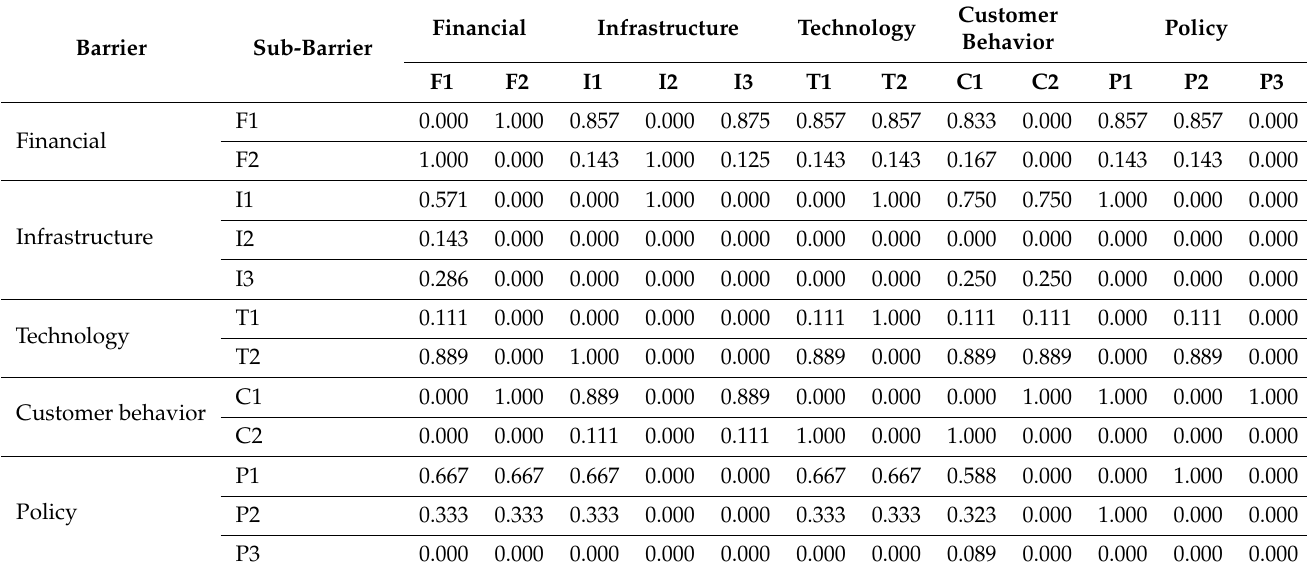
Table 4. Unweighted super-matrix.